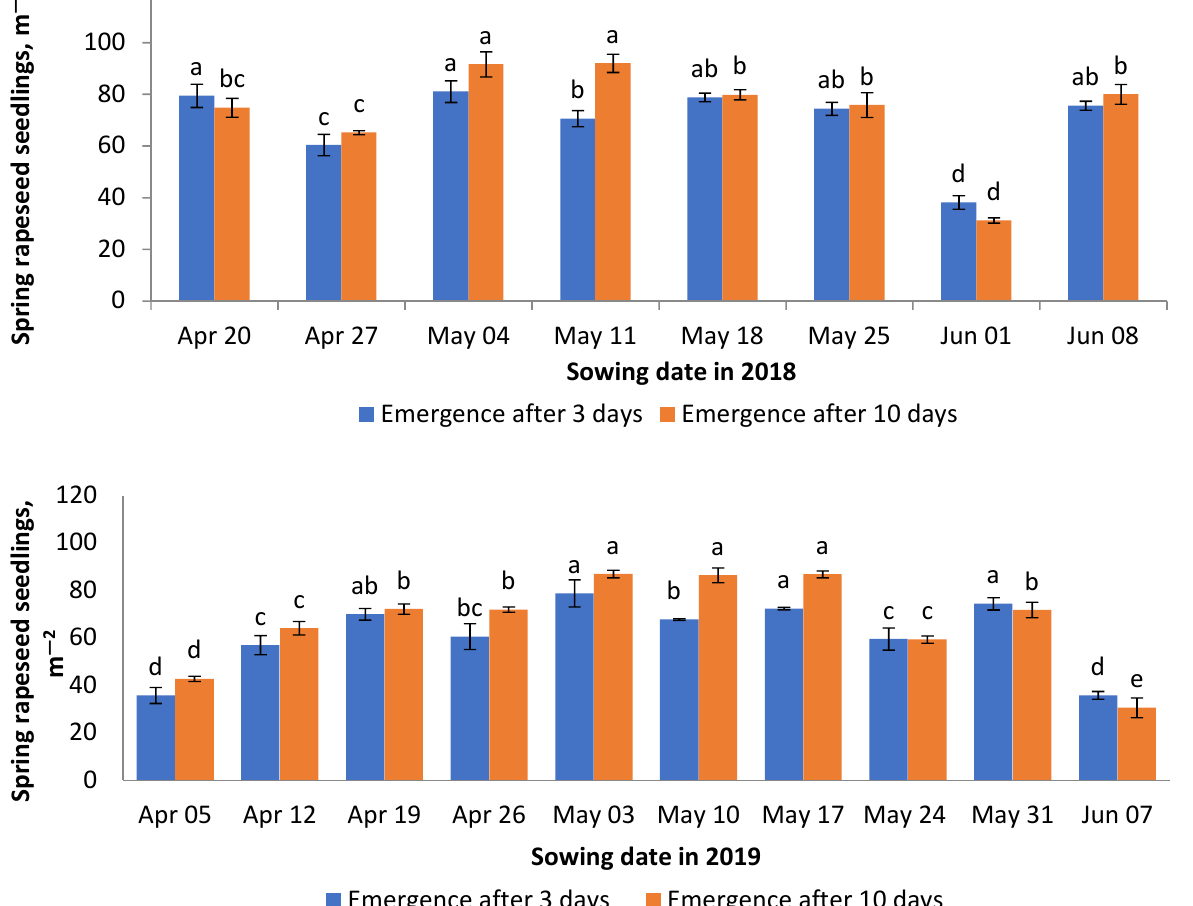
Figure 1. Emergence of spring rapeseed sown at different dates on the 3rd and 10th day from the first plant emergence in 2018 and 2019. Differences between the means of the treatments marked with different letters (a, b, ...) are significant ( p ≤ 0.05); bars indicate standard error of the mean (SEM).